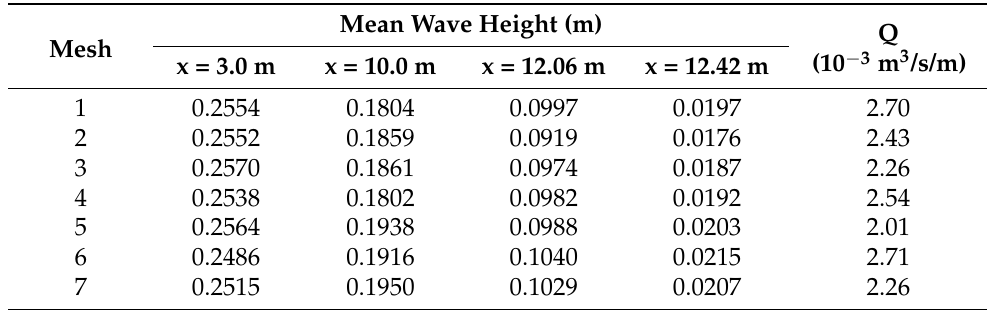
Table 5. Overtopping case: mean wave height at gauges located at x = 3.0, 10.0, 12.06, and 12.42 m and the mean wave overtopping discharge obtained in